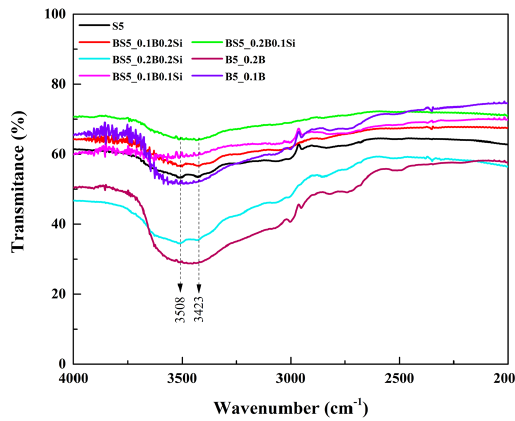
Figure 3. IR spectra in the range of 4000-2000 cm -1 of AFI samples with and without boron added to different compositions.